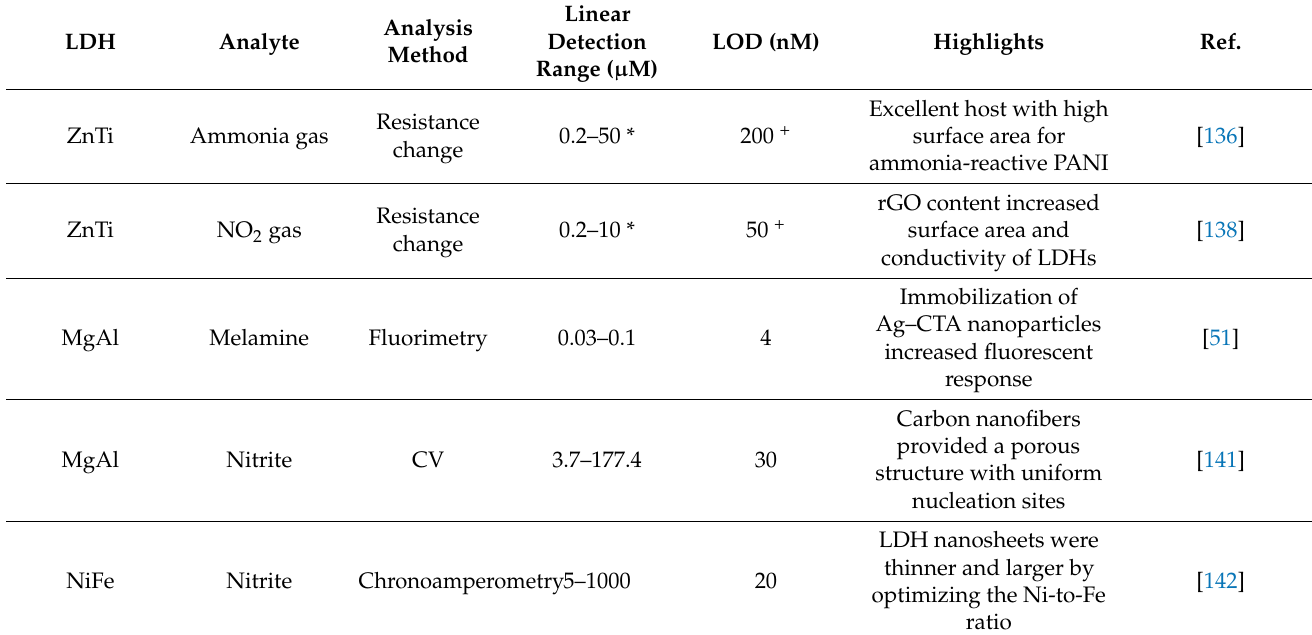
Table 4. The detection performance of LDH-based sensors for nitrogen-based